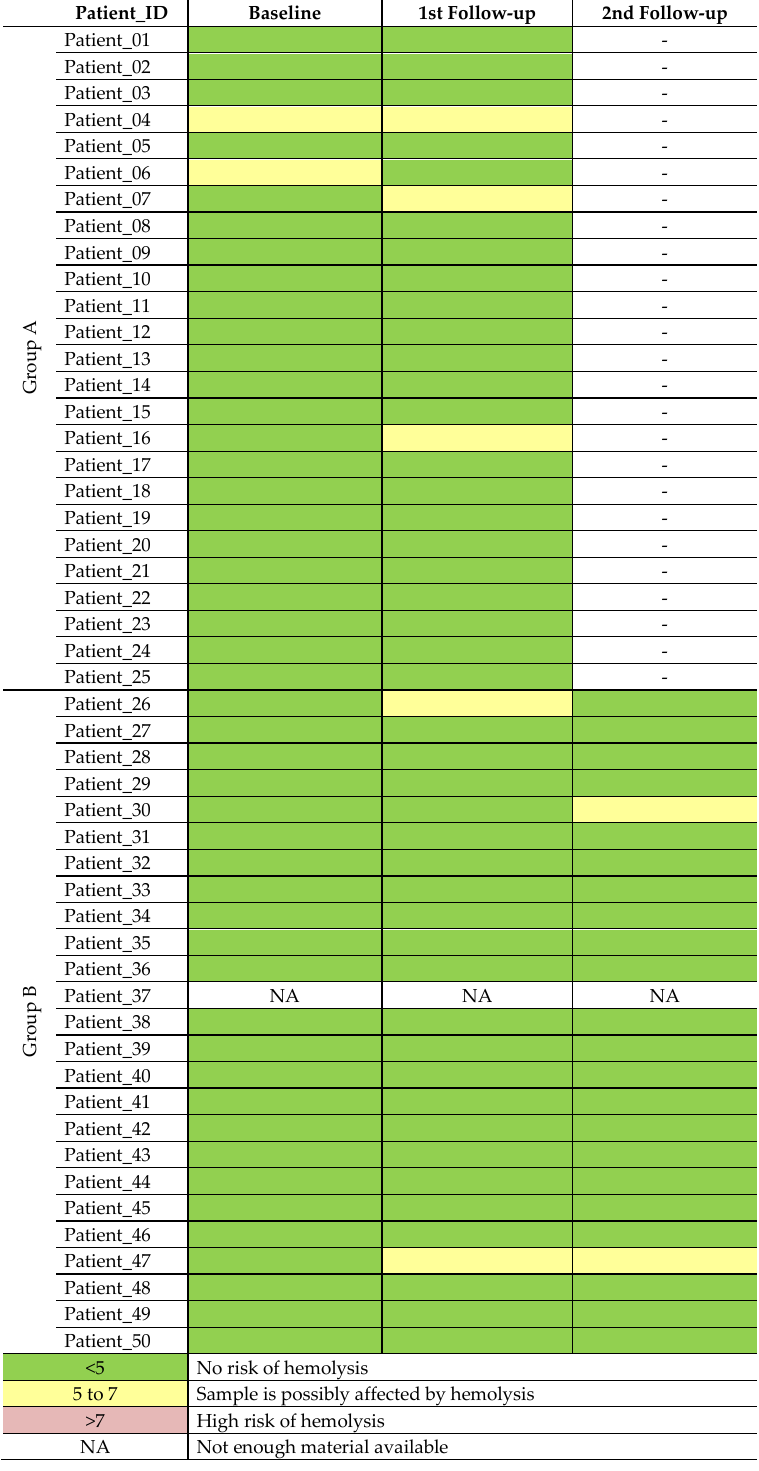
Table A3. Applicability of marker panels at individual time points. Marker